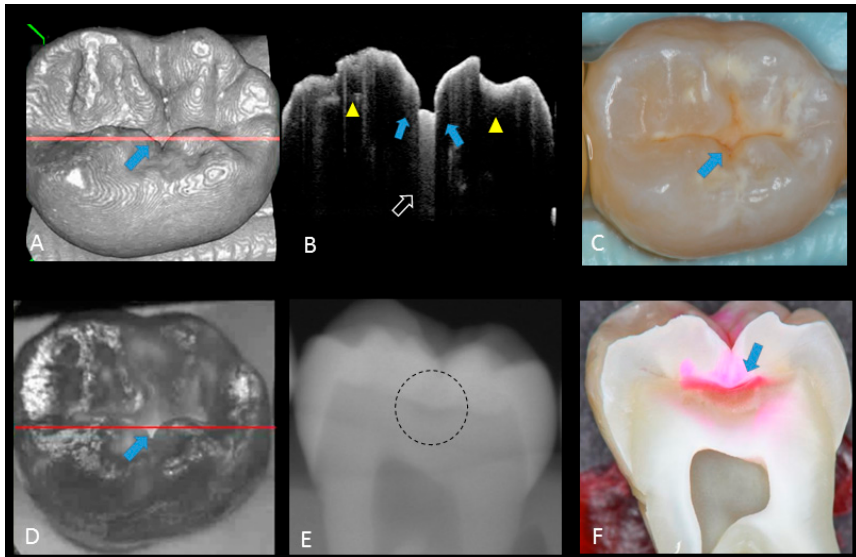
Figure 5. Hidden dentin caries; ( A ) 3D OCT image; ( B ) cross-sectional OCT along the red line in (A) and (D). Bold arrows show cavitated caries with discontinued enamel surface and scattering beyond dentino-enamel junction (DEJ) (triangle). Blank arrow suggests strong scattering from enamel into dentin (score 3); ( C ) photographic presentation of occlusal enamel; ( D ) OCT en face intensity projection; ( E ) dashed circle shows suspected radiolucency beyond DEJ on the radiograph; ( F ) cross-section view with penetration of red dye beyond DEJ, confirming the presence of caries infected dentin (score 3). The dynamic slicing 3D video is presented in Supplementary Materials: Video 5.